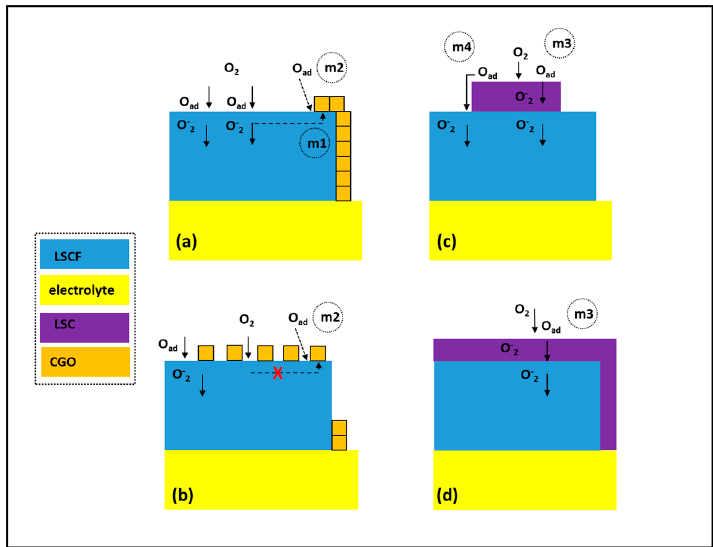
Figure 1. Possible mechanisms contributing to the O 2 redox reaction by infiltration of ( a , b ) ion conductive phase (e.g., Gd-doped ceria (CGO) (m1—extension of three-phase boundary (TPB); m2—adsorption / dissociation at TPB)) and ( c , d ) mixed ionic electronic conductor (MIEC) phase (e.g., La 0.6 Sr 0.4 CoO 3 − δ (LSC) (m3—adsorption / dissociation; m4—spillover migration)).